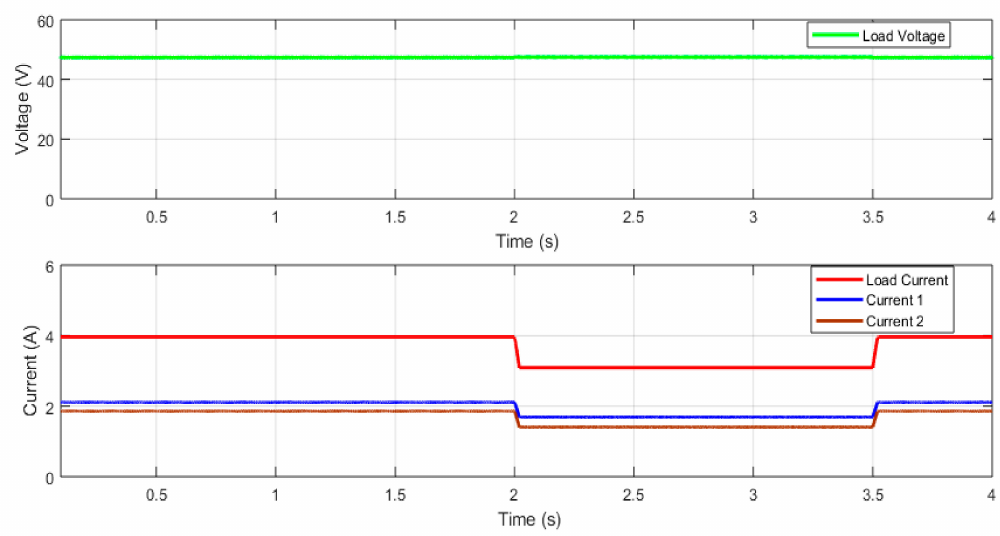
Figure 10. Simulation results for variation in load with different cable resistances for novel droop control: load voltage, converter output currents and load current.